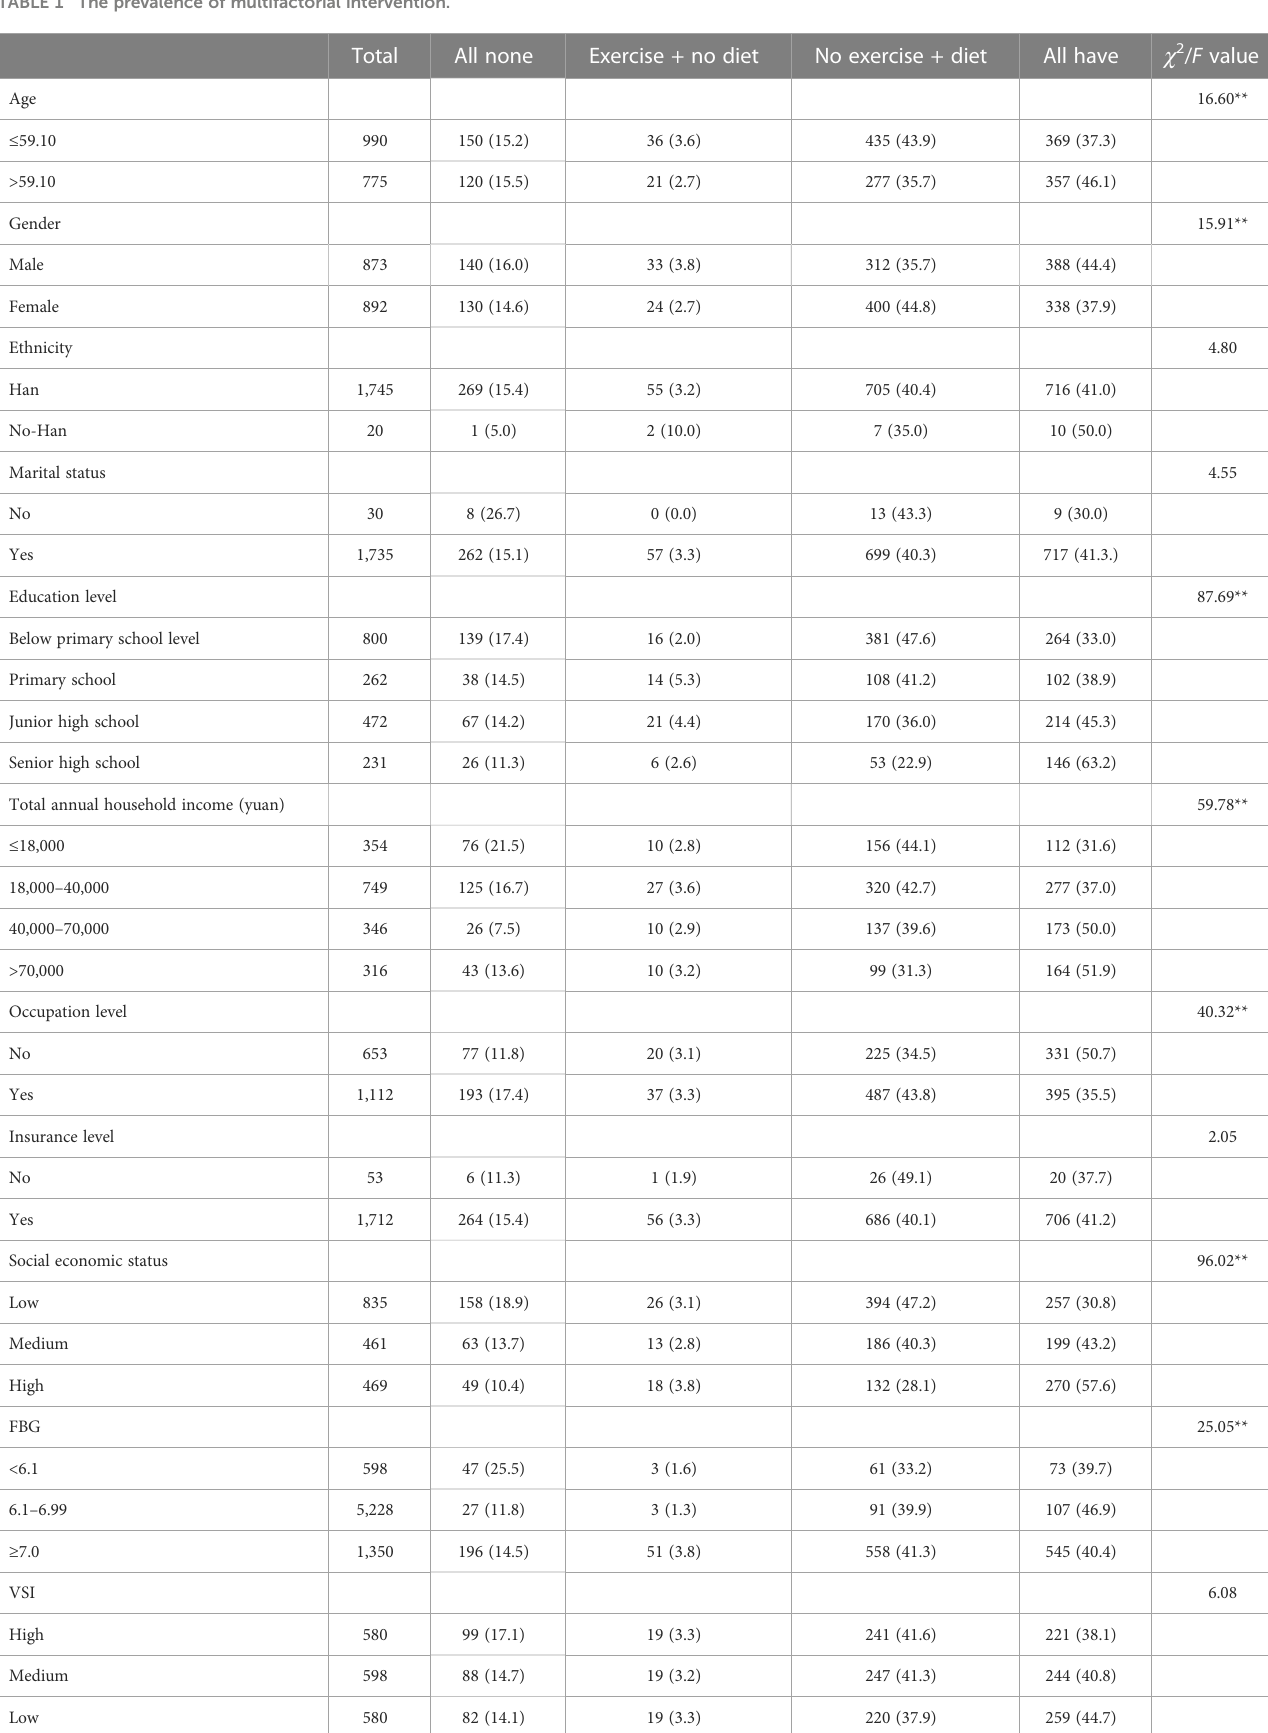
TABLE 1 The prevalence of multifactorial